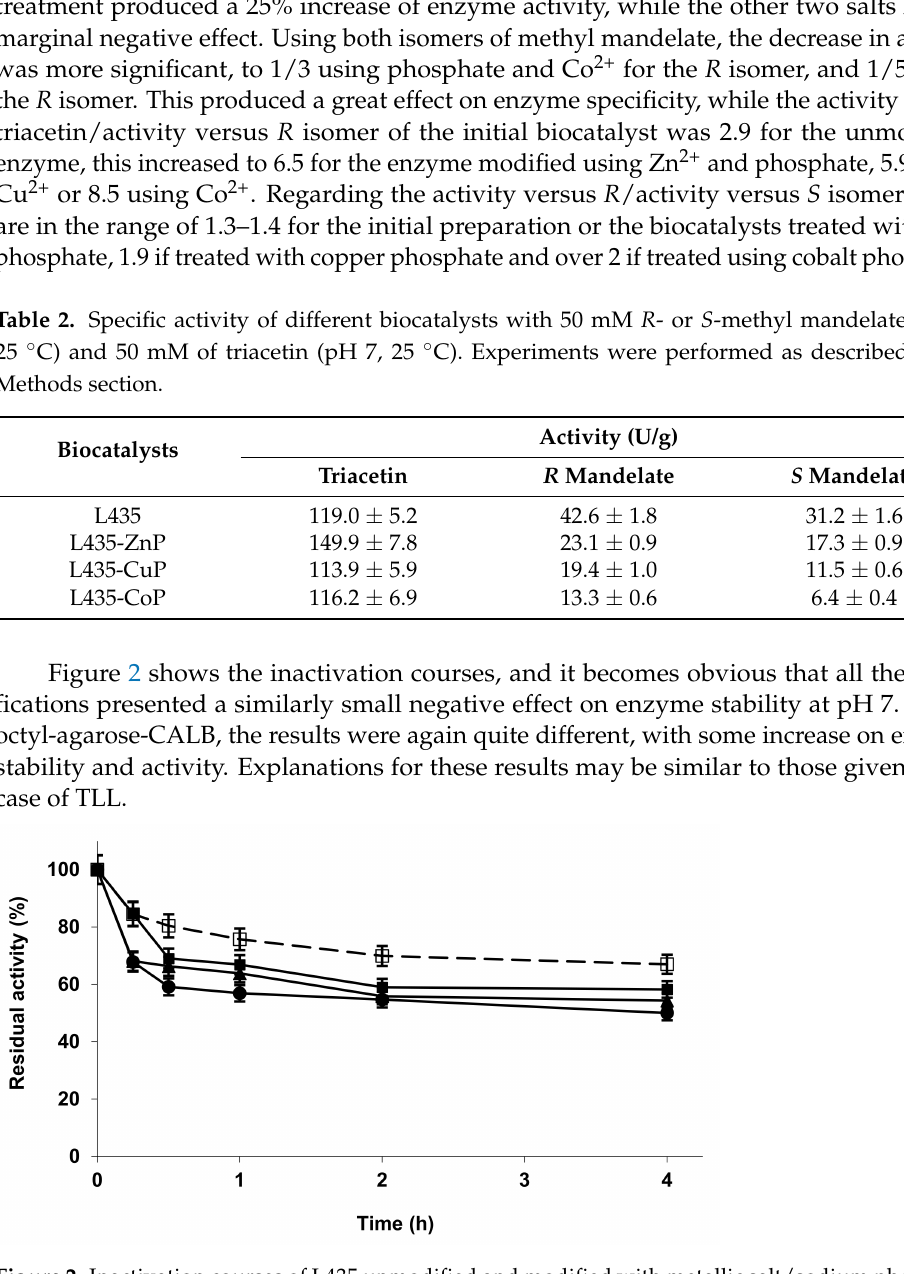
Figure 2. Inactivation courses of L435 unmodified and modified with metallic salt/sodium phosphate. The inactivation was performed with 10 mM Tris buffer at pH 7.0 and 75 ◦ C. Other specifications are described in the Methods section. Unmodified L435 (open squares and dotted line); L435 modified with ZnCl 2 /sodium phosphate (solid squares); CuCl 2 /sodium phosphate (solid circles); CoCl 2 /sodium phosphate (solid